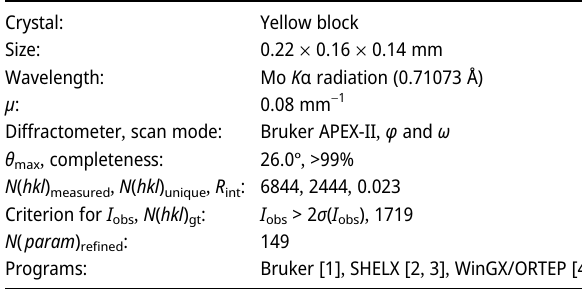
Table 1 contains crystallographic data and Table 2 contains the list of the atoms including atomic coordinates and displacement parameters.